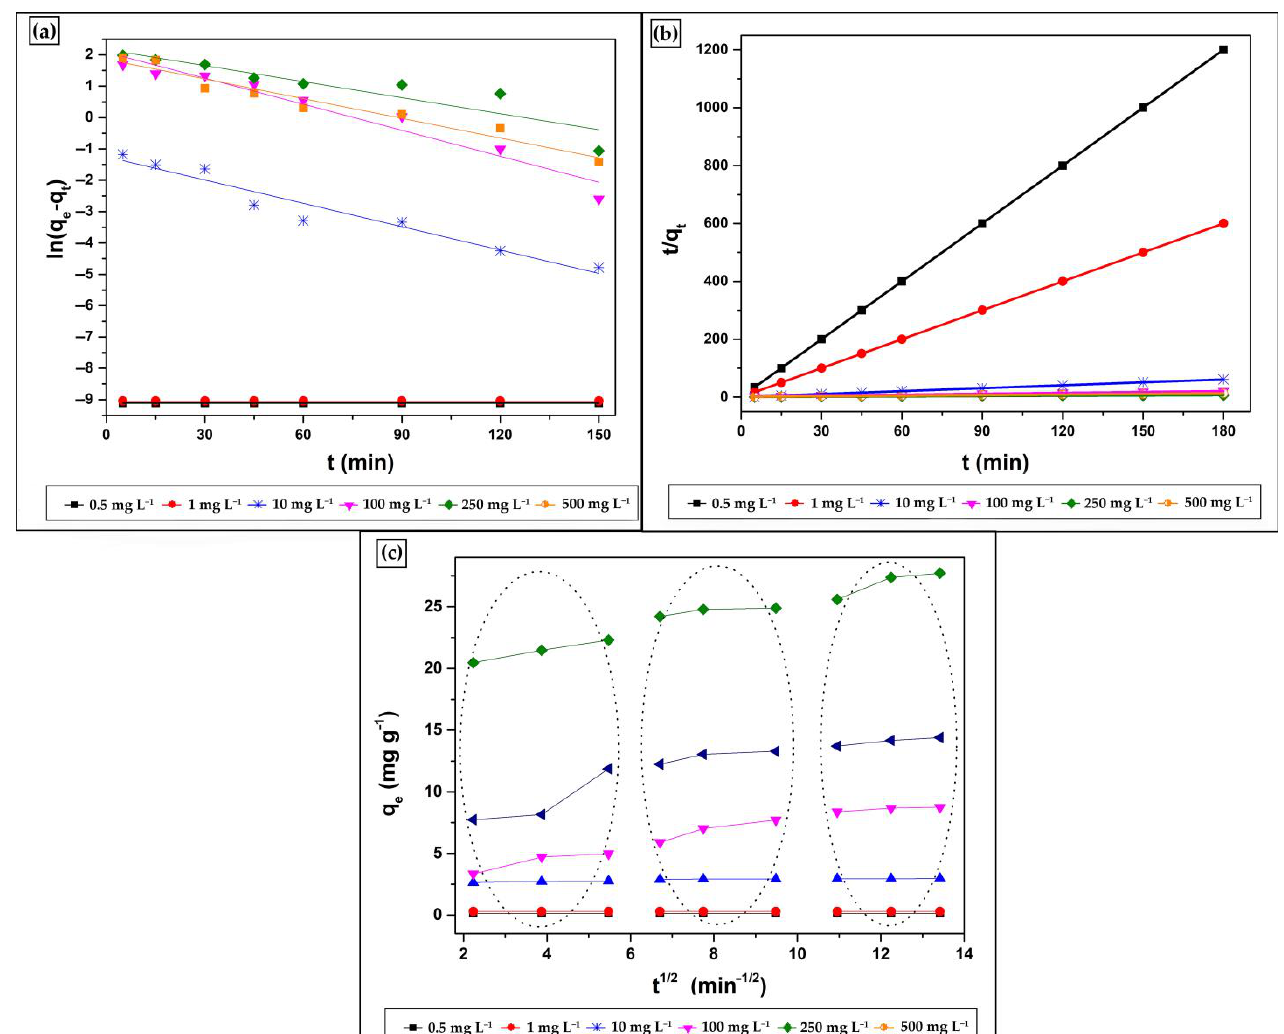
Figure 9. Pseudo-First Order ( a ), Pseudo-Second Order ( b ) and Weber-Morris Intra-Particle Diffusion ( c ) kinetic models used to describe CV adsorption on MNP@PAAA-FA. The initial CV concentrations were 0.5, 1, 10, 100, 250 and 500 mg L − 1 using 100 mg of adsorbent at 298 K and 700